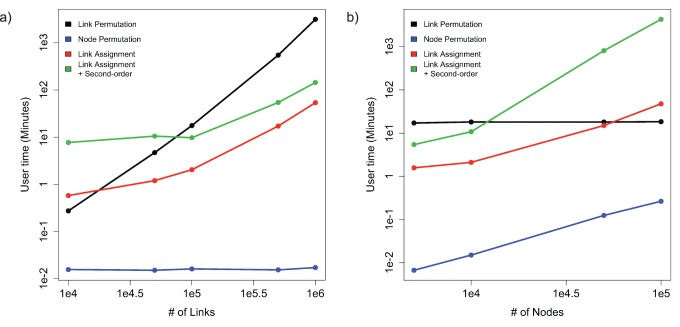
Software performance for 150 randomizations for each of the four methods.a) Computational performance with increasing number of links and constant number of nodes. The node permutation method is independent of the number of links and only depends on the number of nodes. b) Computational performance with increasing number of nodes and constant number of links. The link permutation method is independent of the number of nodes and only depends on the number of links.